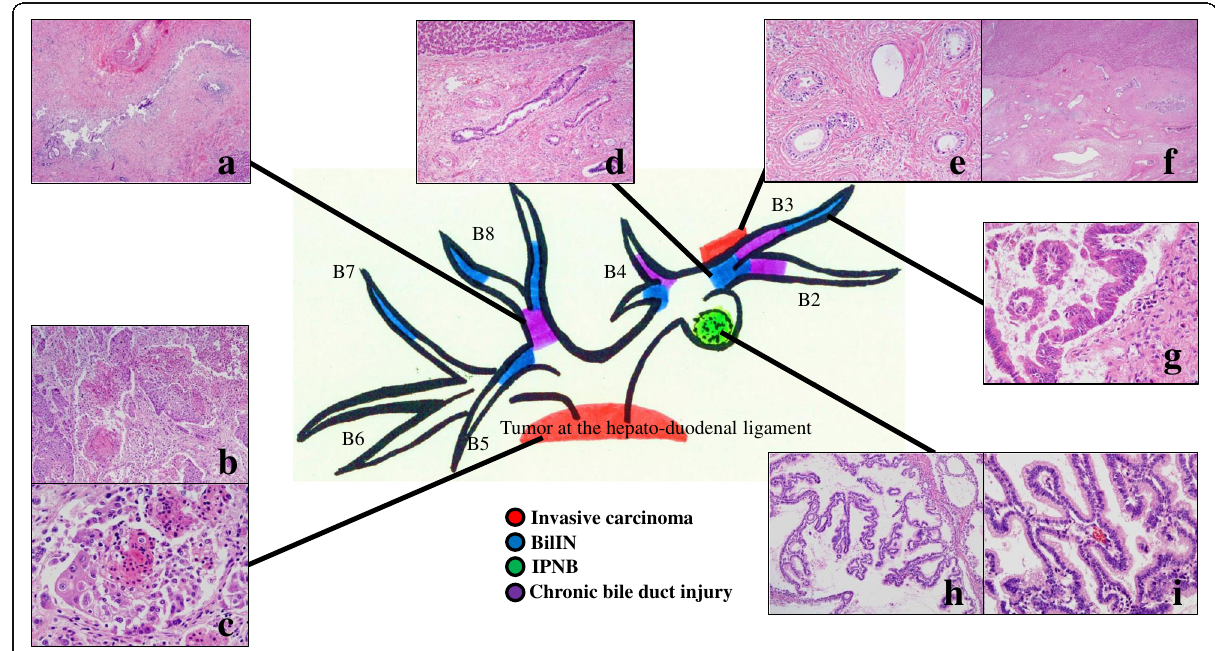
Fig. 4 Mapping chart of atypical bile duct epithelium. a Chronic bile duct injury as sclerosing cholangitis revealed in the proximal side of segment 8 (B8). b , c The enlarged lymph node in the hepatoduodenal ligament was diagnosed as a poorly differentiated adenocarcinoma with partial differentiation of the squamous epithelium. d Biliary intraepithelial neoplasia (BilIN) at the proximal side of segment 3 (B3). e , f Well- differentiated tubular adenocarcinoma at the stromal side of Glisson ’ s sheath around the proximal side of B3. g BilIN at the peripheral side of B3. h , i Intraductal tumor with cystic dilatation of the proximal side of the bile duct in segment 2 (B2) was intermediate-grade intraductal papillary neoplasm of the bile duct without any